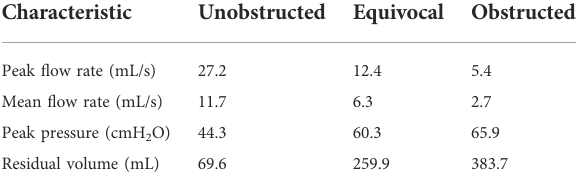
TABLE 1 Characteristics of the pressure- fl ow test at different BOO